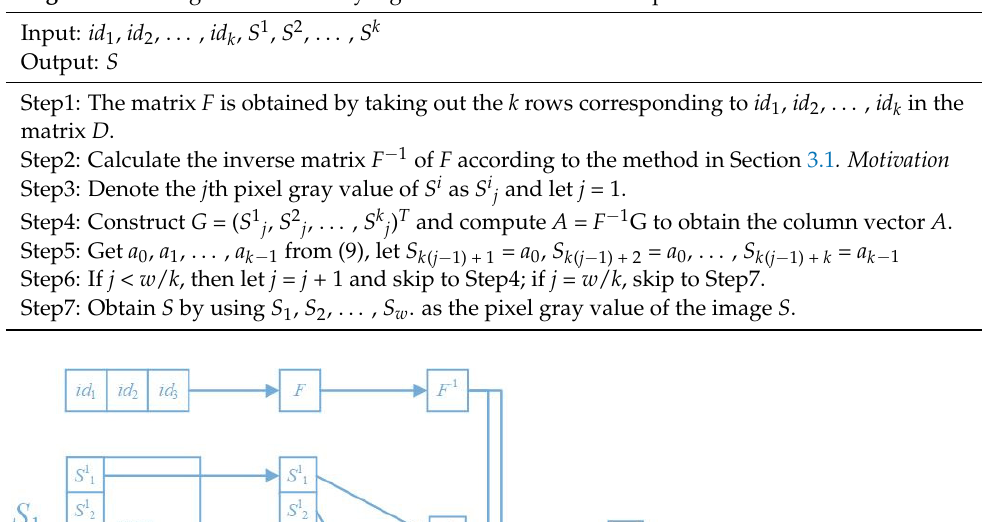
Figure 2. We assume that the identities of the participants involved in recovery are id 1 , id 2 , and id 3 . Algorithm 4 Image secret recovery algorithm based on matrix operations Algorithm 4 Image secret recovery algorithm based on matrix operations